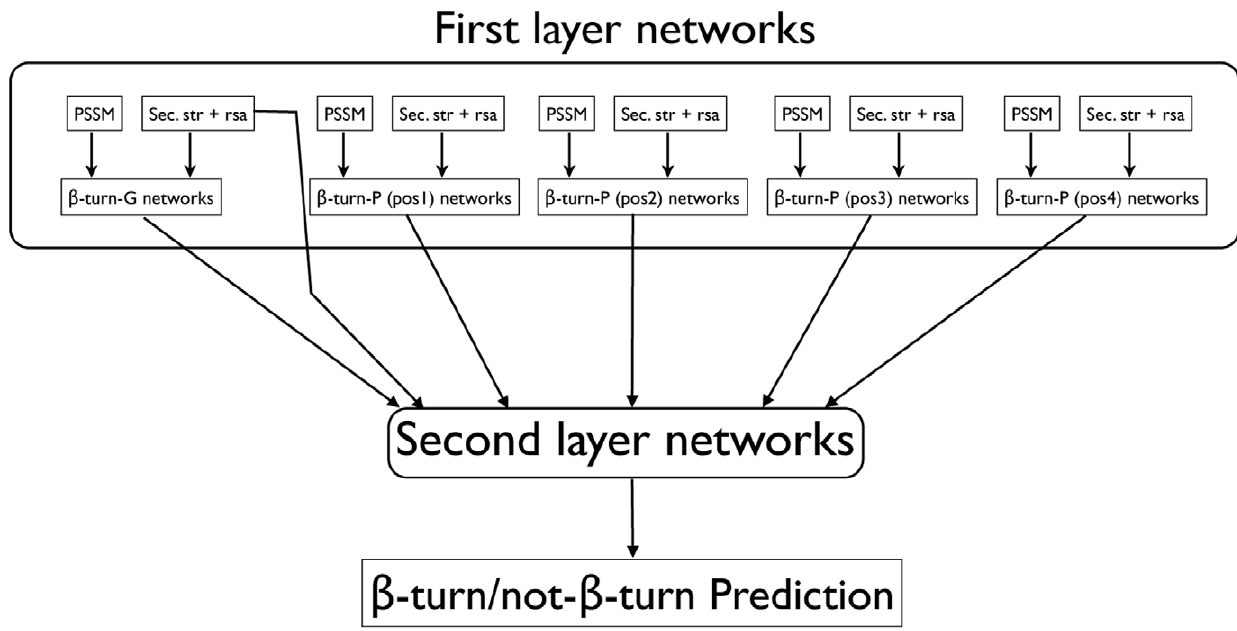
Figure 1. Graphical overview of the method used in training of the first and second layer networks. ‘PSSM’ is a Position-Specific Scoring Matrix. ‘Sec. str + rsa’ is secondary structure and surface accessibility predictions obtained from NetSurfP [28]. Networks with the abbreviation ‘pos’ refer to networks that predict specific positions in a b -turn. First layer networks are all ensembles of artificial neural networks where output was used for training in the second layer networks.